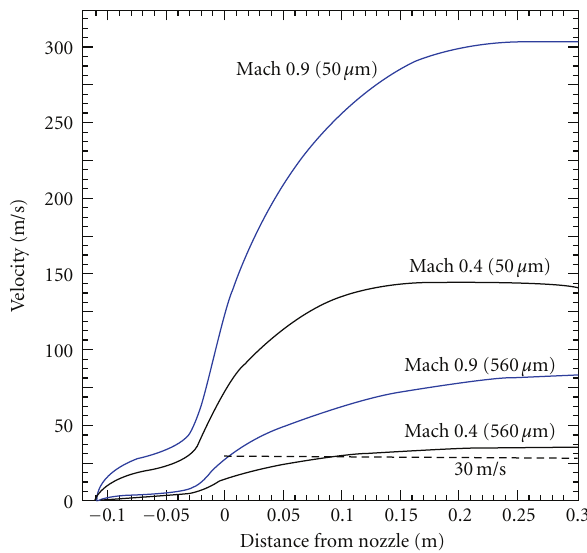
Figure 11: Particle velocity as a function of distance from the nozzle for Mach numbers of 0.4 and 0.9, and particle diameters of 50 and 560 microns in an unducted burner rig. The minimum recommended particle velocity of 30 m/s for erosion studies is shown by the dashed line.